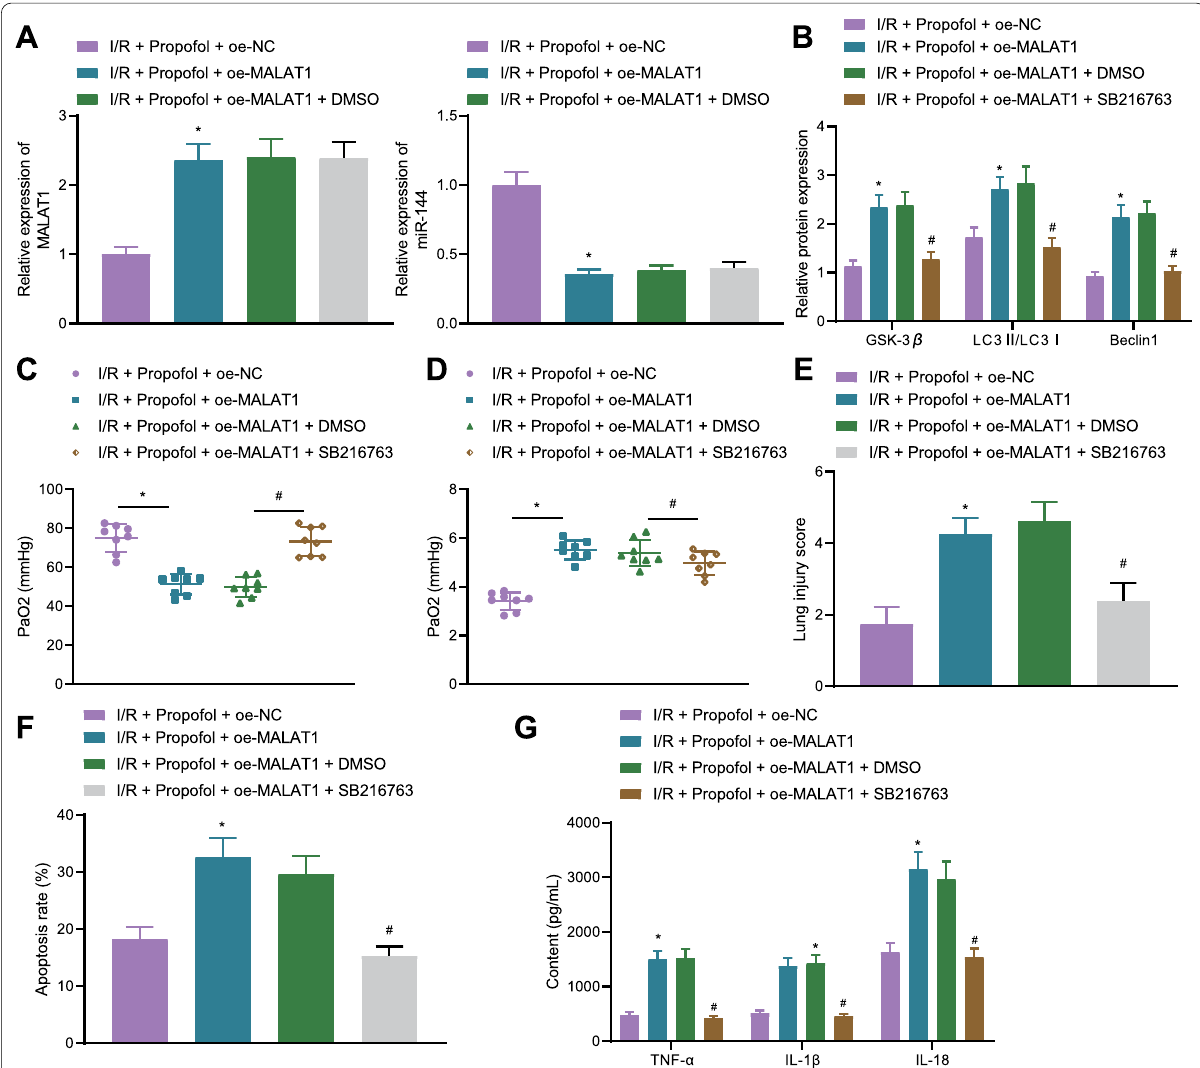
Fig. 6 Propofol relieved lung I/R injury in mice through the MALAT1/miR‑144/GSK3β axis. A Expressions of MALAT1 and miR‑144 in mice as detected by RT‑qPCR (8 mice in each group; * p < 0.05, compared with that of the I/R as detected by Western blot analysis (8 mice in each group; * p < 0.05, compared with that of the I/R with I/R Propofol oe‑MALAT1 DMSO group). C PaO 2 in mice (8 mice in each group; * p < 0.05, compared with the I/R + + + group; # p < 0.05, compared with